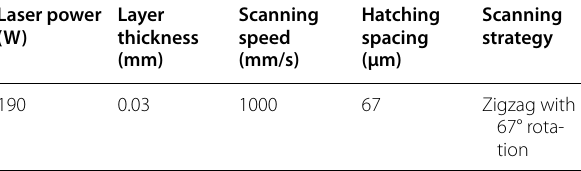
Table 1 Parameters of SLM for building the Ti6Al4V alloy workpieces